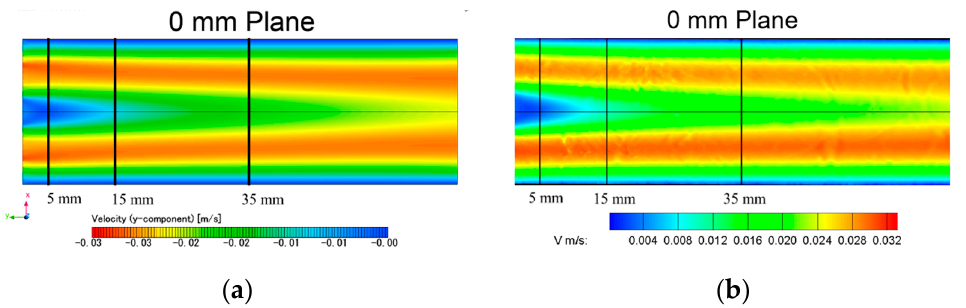
Figure 5. Velocity distribution comparison in the middle plane of the tube: ( a ) CFD simulation; ( b ) PIV experiment. Table 1. V-velocity validation between CFD and PIV at 5 mm, 15 mm, and 35 mm downstream of the inlet.